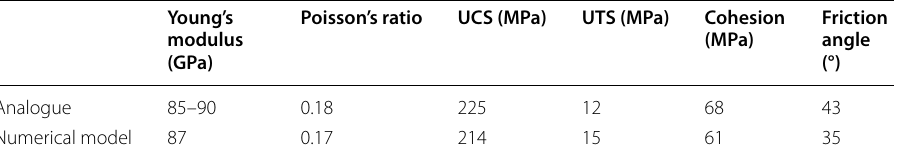
Table 3 Mechanical properties of the selected analogue rocks and of the numerical rock model